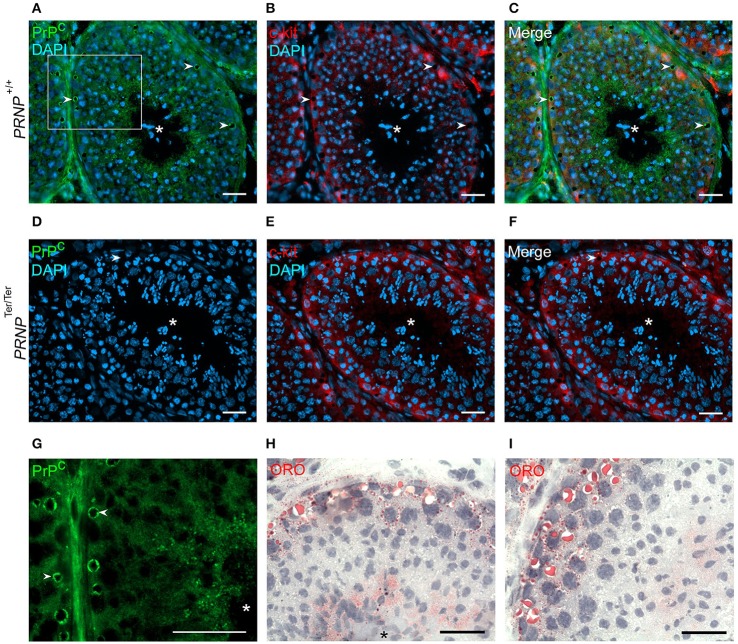
PrPC is distinctly present in lipid vesicles and vacuoles in seminiferous tubules. Immunofluorescence analysis of testicular tissue demonstrates the presence of PrPC
(A) green, and the stem-cell marker c-kit (B) red, cell nuclei counterstained with DAPI (blue) and merged (C) in PRNP+/+ bucks. Spermatogenic stem cells positive for c-kit+ were distributed along the basement membrane and appeared to express low levels of PrPC. However, PrPC was prominently present in small vesicles on the luminal aspect and in larger Sertoli cell vacuoles (arrowheads) along the periphery of the tubules, as highlighted by digital magnification (G) of rectangle depicted in (A). Both the vesicles and vacuoles (arrowheads) contain lipids, as shown by ORO-staining (H,I). Testis from PRNPTer/Ter bucks is negative for PrPC and show similar distribution of c-kit and harbor similar vacuoles (arrowheads) as PRNP+/+ bucks (D–F). Asterisk: Lumen of seminiferous tubules. x400 (all except G which was digitally magnified to x1,000). Scale bars 25 μm.